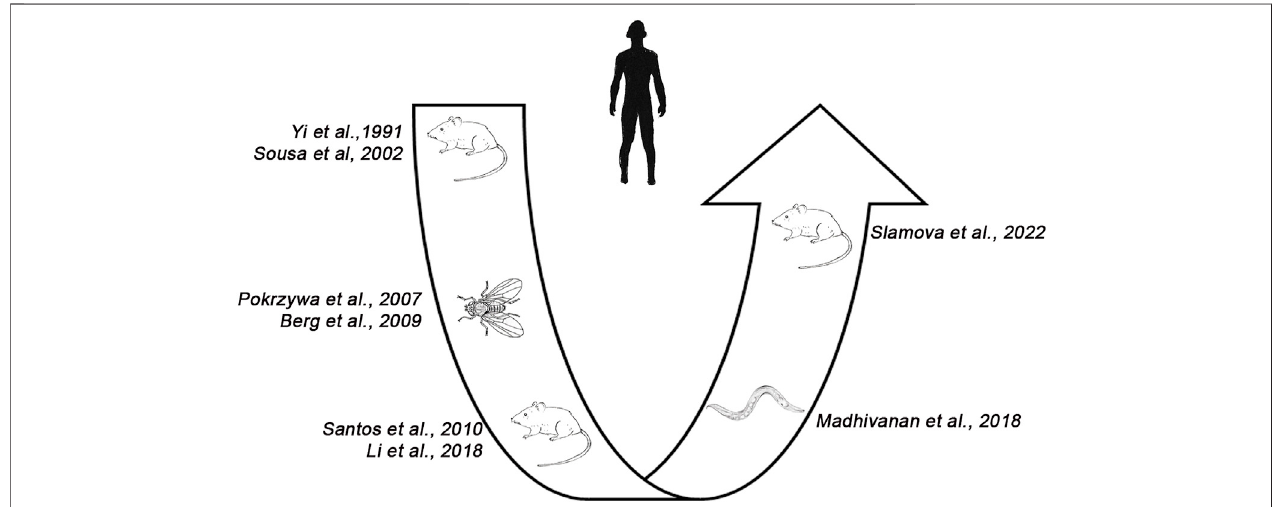
FIGURE8| DevelopmentofanimalmodelsforATTRinhumans.Fromthe fi rstmousemodel(Yietal.,1991),severalattemptsweremadetoreproducethedisease in invertebrates (i.e., C. elegans , Drosophila melanogaster ) before developing a novel transgenic mouse model reproducing amyloid in the heart and tongue (Slamova et al.,